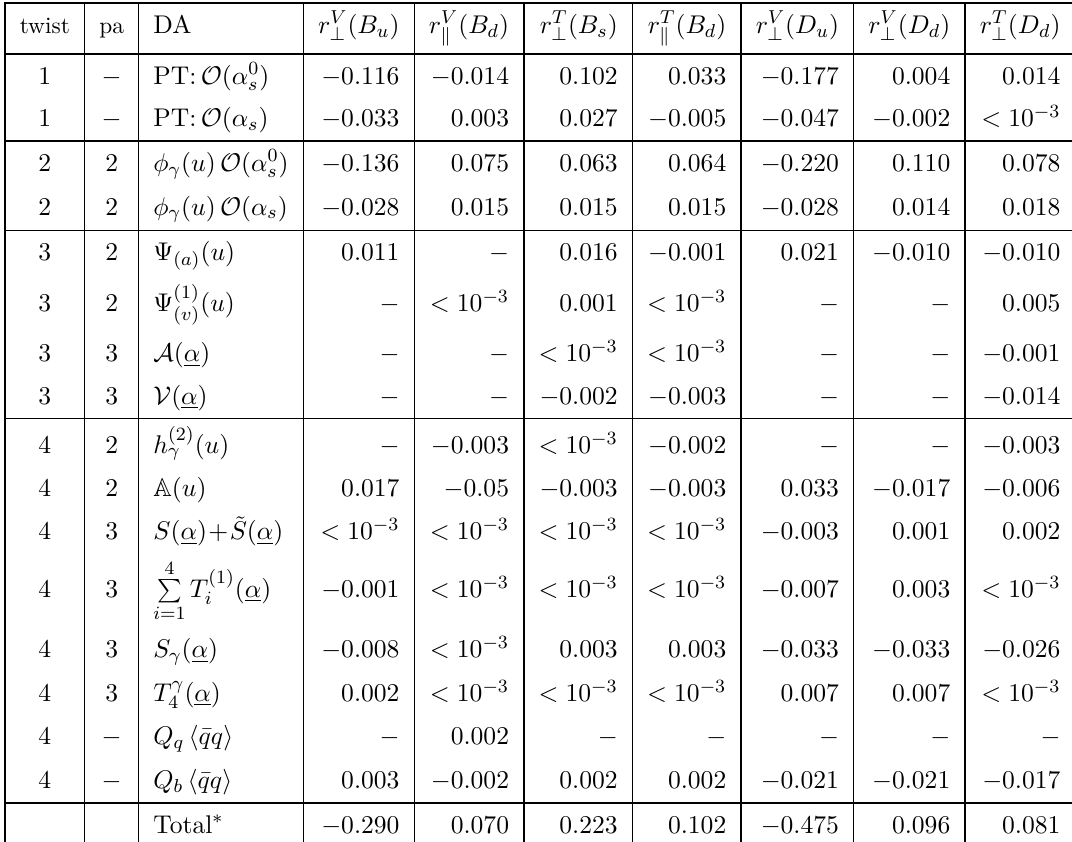
Table 3 . A breakdown of contributions according to twist, “pa” = number of partons and the specific DA. The definitions of the DAs can be found in [3]. The asterisk in total is a reminder that it does not include twist- 4 contributions not closing under the equations of motion cf.